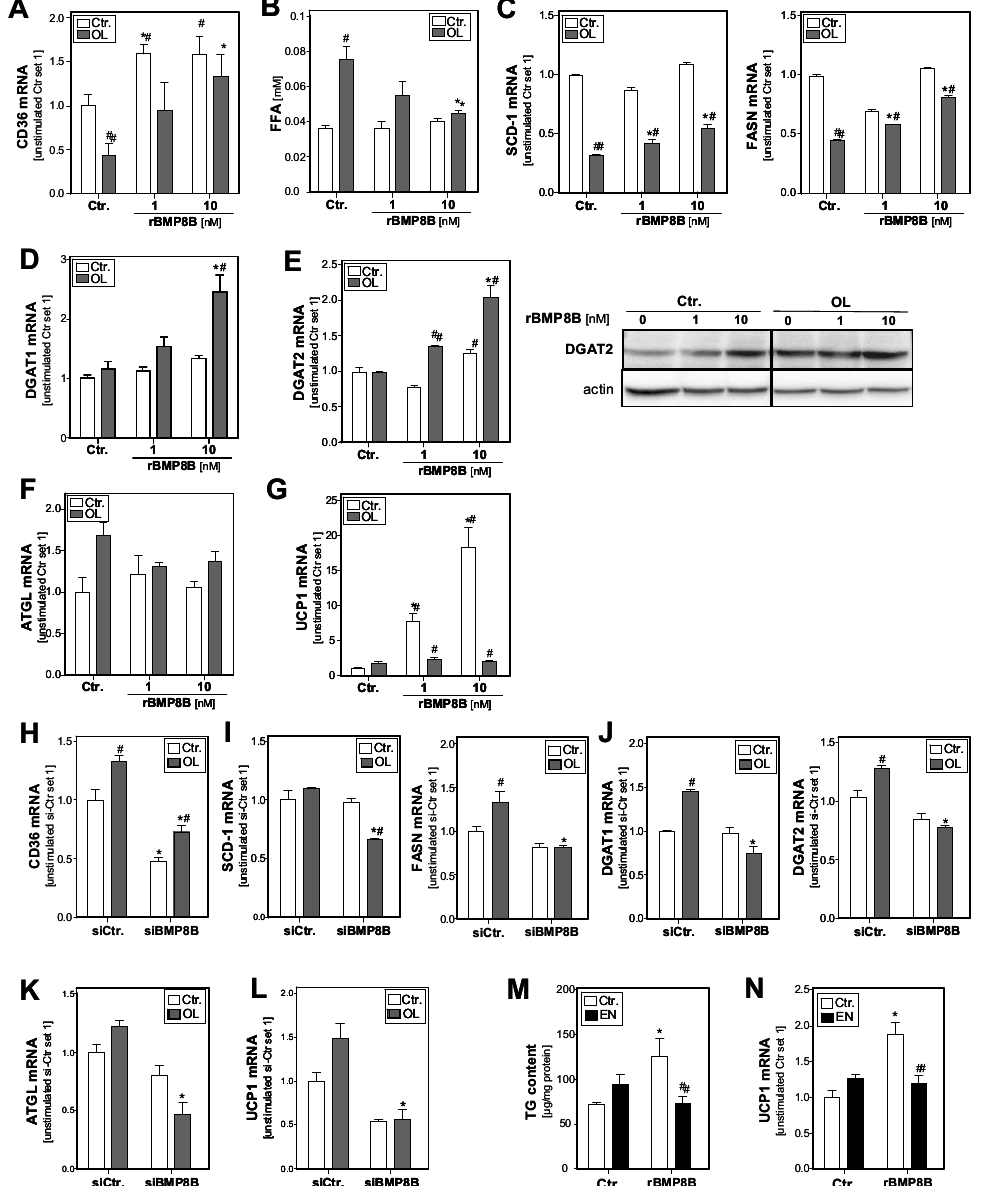
Figure 3. Effect of BMP8B (depletion) on hepatocellular lipid metabolism. ( A – G ): PHH were incubated with OL (0.4 mM) for 24 h in the presence or absence of recombinant rBMP8B. ( H – L ): BMP8B mRNA expression was depleted in HepG2 hepatoma cells by transfection with si-RNA (si-BMP8B); control cells were transfected with control-siRNA (si-Ctr). Subsequently, the cells were incubated with or without 0.4 mM OL for additional 24 h. ( M – N ): HepG2 cells were incubated with rBMP8B (10 nM) for 24 h in the presence or absence of epinephrine (EN; 100 nM). mRNA levels of ( A , H ) CD36, ( C , I ) SCD1 and FASN, ( D , E and J , left panel) DGAT1 and DGAT2, ( F , K ) ATGL, and ( G , L ) UCP1 analyzed by quantitative RT-PCR; ( B ) Free fatty acids levels in cell culture supernatant; ( E , right panel) Western blot analysis of DGAT2 protein levels; ( M ) Cellular TG content normalized to protein content; ( N ) mRNA levels of UCP1. ( A – G ): * p < 0.05 compared with the corresponding condition without BMP8B stimulation; # p < 0.05 compared with the corresponding condition without OL stimulation; ( H – L ): * p < 0.05 compared with si-Ctr-transfected cells; # p < 0.05 compared with cells without OL stimulation. ( M – N ): * p < 0.05 compared with cells without rBMP8B stimulation; # p < 0.05 compared with cells without epinephrine stimulation; two-way